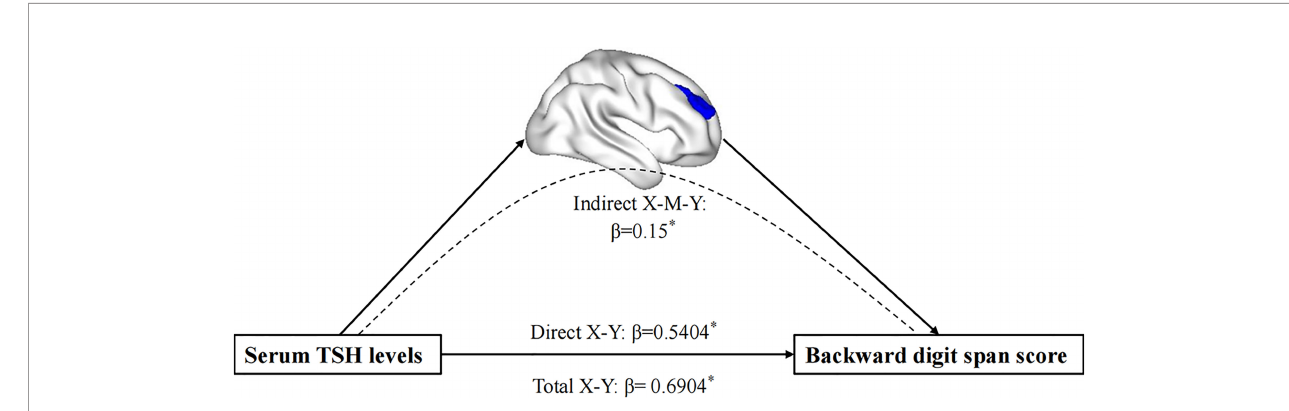
FIGURE 2 | The mediation analysis result. It demonstrates that the GM density of the right MFG mediated the impact of the decreased TSH levels on EF performance in MDD patients. MFG, middle frontal gyrus; EF, executive function. *P < 0.05.